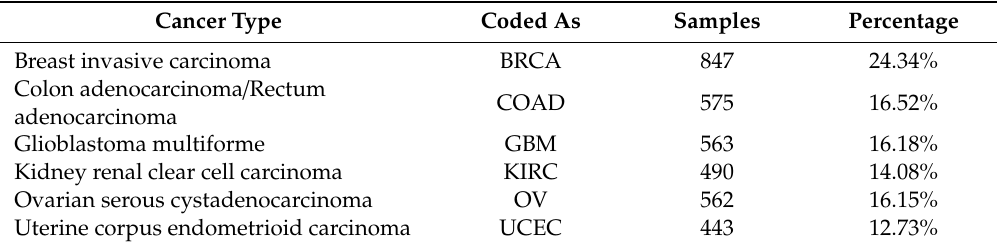
Table 1. Number of samples and their percentages of each of the six cancer types.